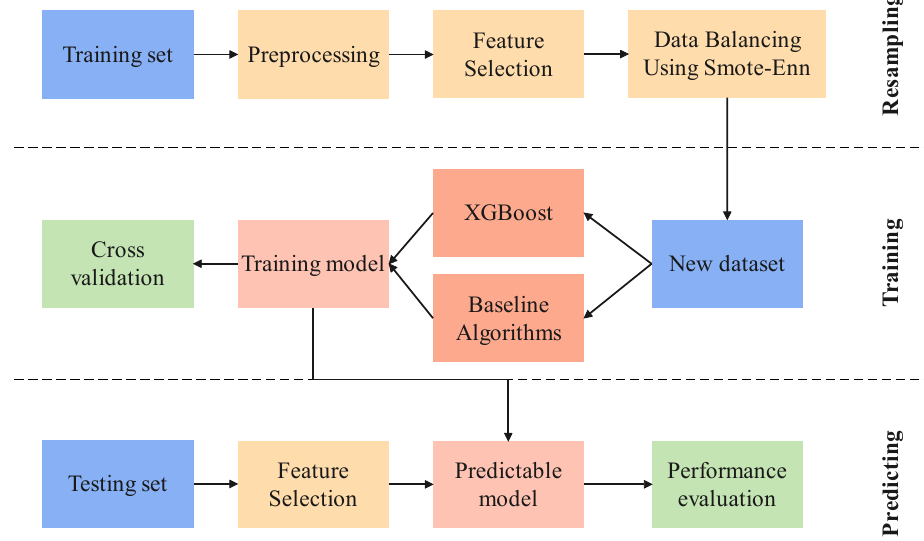
Figure 1. The process of the proposed framework.